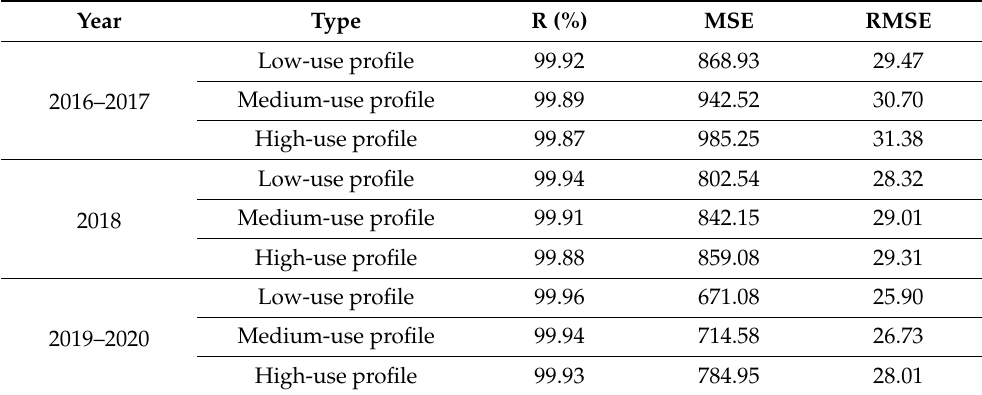
Table 8. Evaluating the performance of the ELM network based on various performance evaluation